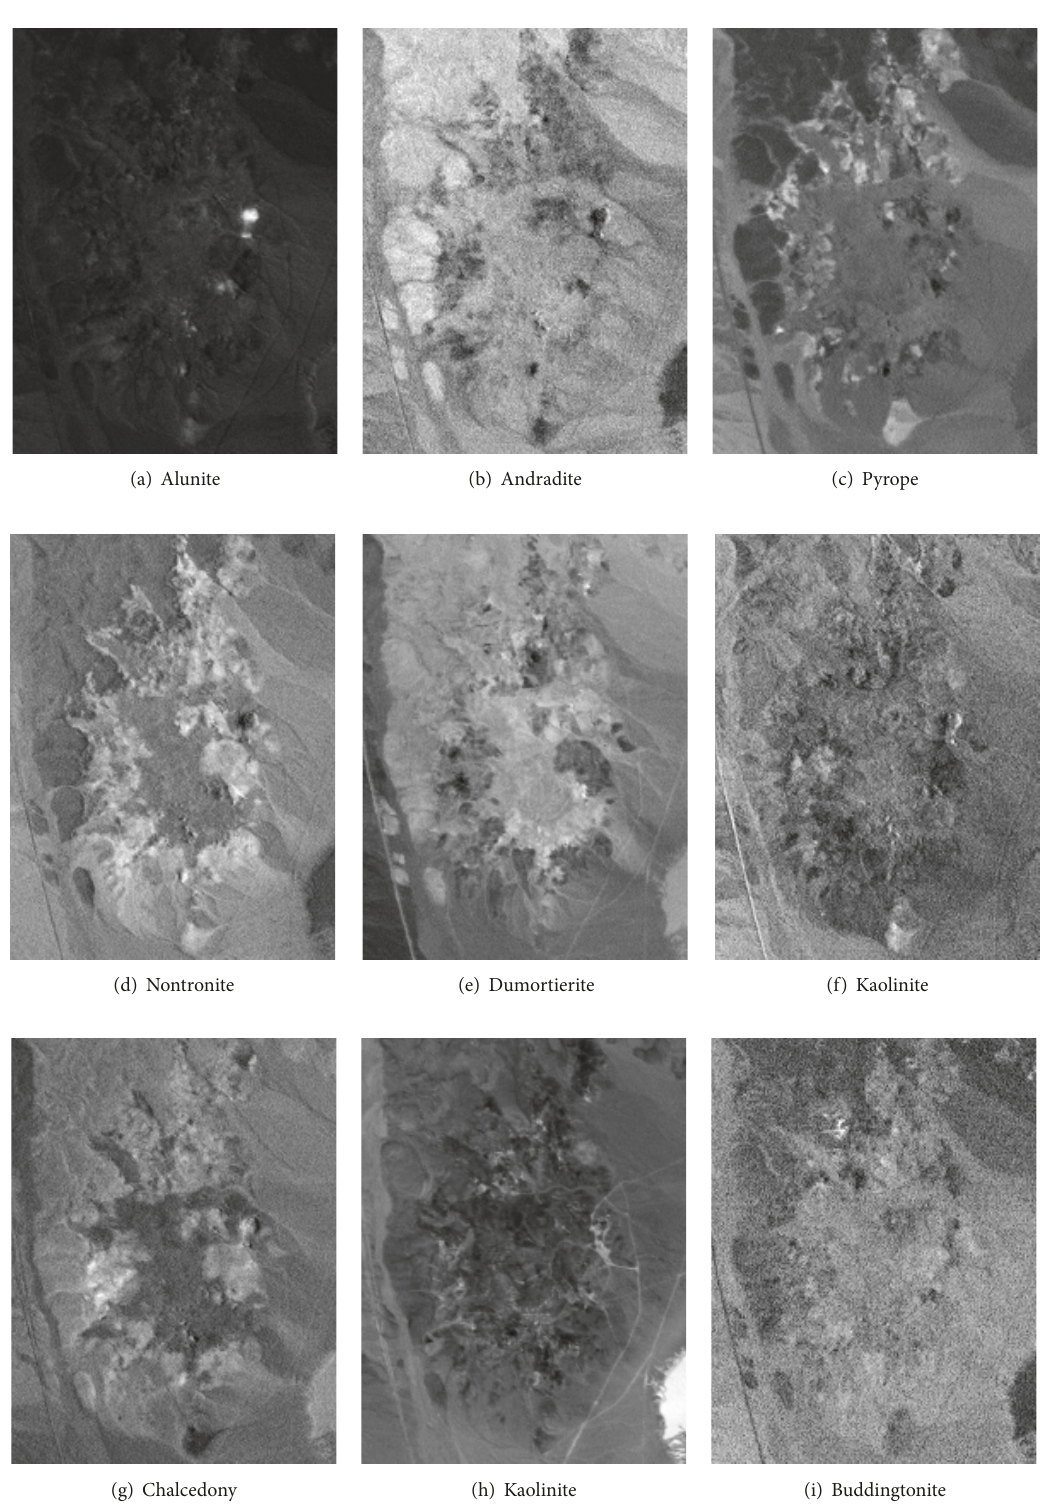
Figure 8: The results from different elements abundance in hyperspectral unmixing